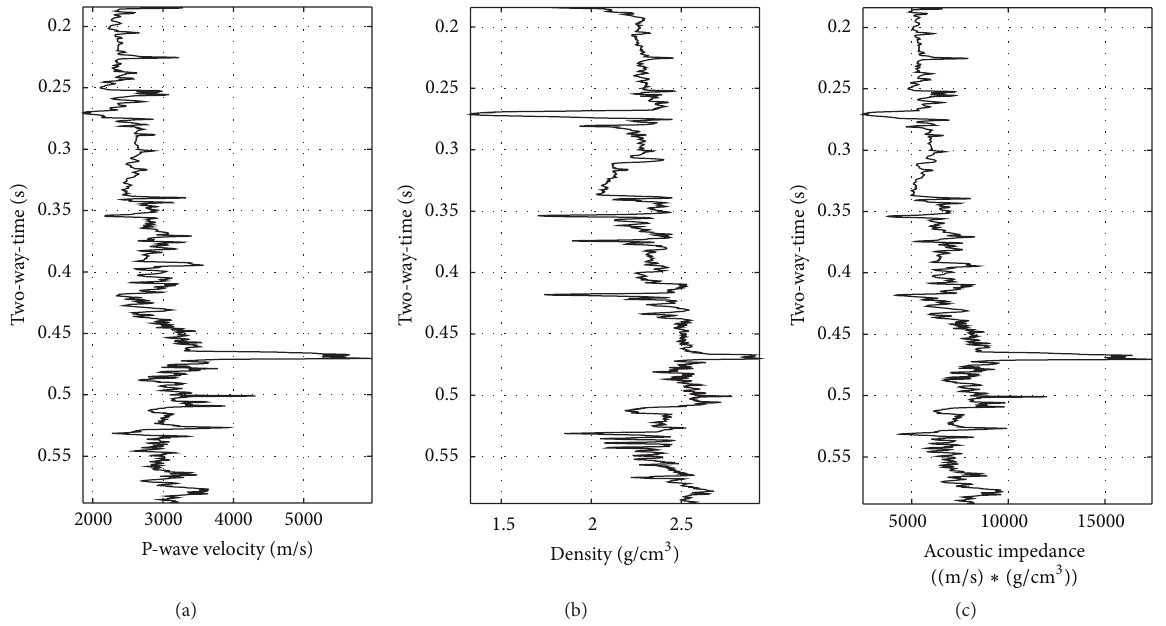
Figure 7: Acoustic impedance log (right) derived from the sonic and density logs (left and middle) of Ktzi202. The sonic and density logs are median filtered and converted from depth to two-way-time. Since the location of the K2 of the 3D surface seismic varies in time, the two- way-time function is shifted to the K2 for each trace. Here, as an example, the adjustment to the stacked zero-offset VSP baseline is shown (Figure 8, top left